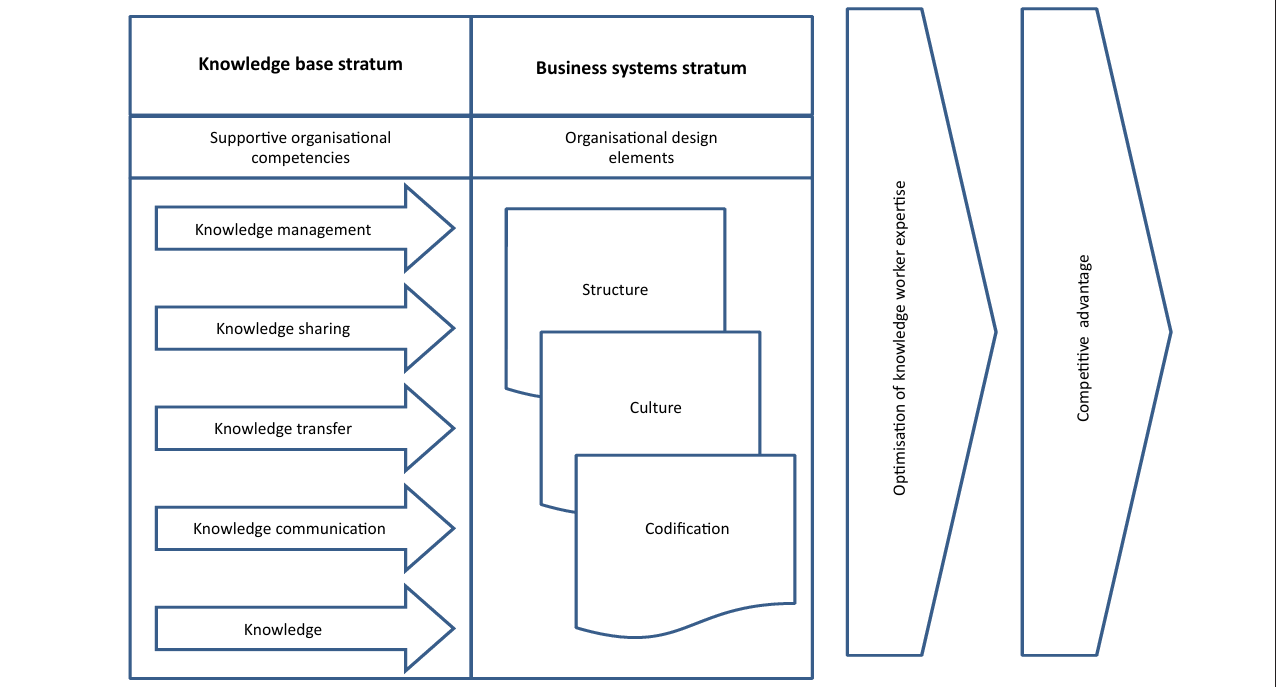
FIGURE 1: A framework for optimising the expertise of knowledge